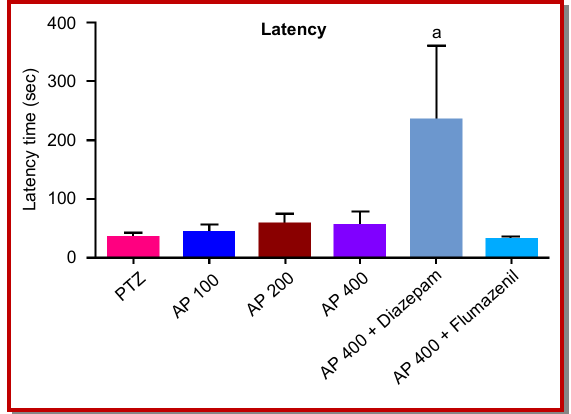
Figure 1: Comparison of seizure latency between studied groups; * significant difference compared to pentylenete - trazole (PTX) group ( a p<0.001); AP= A.